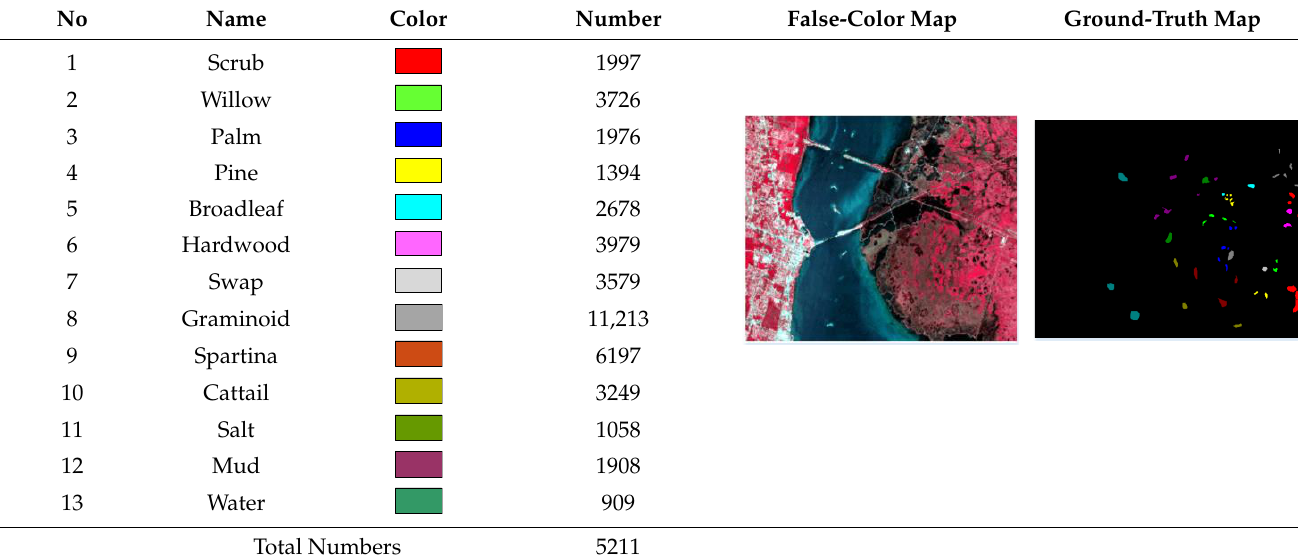
Table 2. KSC Dataset Labeled Sample Counts.